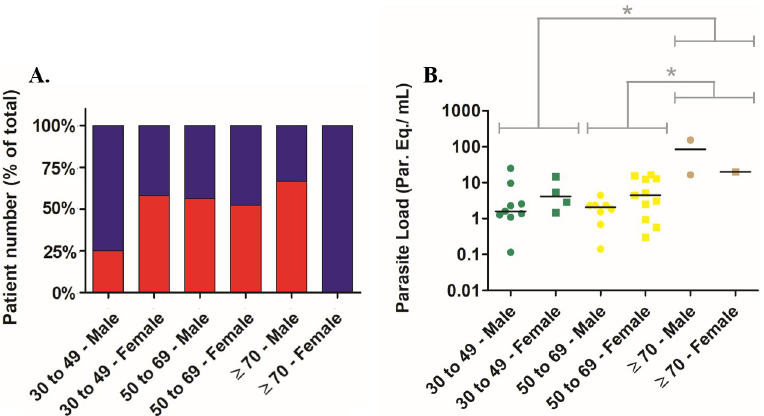
Fig 2. Clinical manifestations and parasite load in chronic patients grouped by age and gender. In A, clinical manifestations grouped by patients age and gender. Red bars: patients with cardiac form (CCC). Blue bars: patients with indeterminate form. In B, parasite load in blood of patients grouped by age and gender: Green symbols: from 30 to 49 years old; Yellow symbols: from 50 to 69 years; Brown symbols: over 70 years old. ( ● ) Male patients, ( ■ ) Female patients. The horizontal lines represent the parasite load median values. � P < 0.05 (Mann-Whitney Rank Sum test).